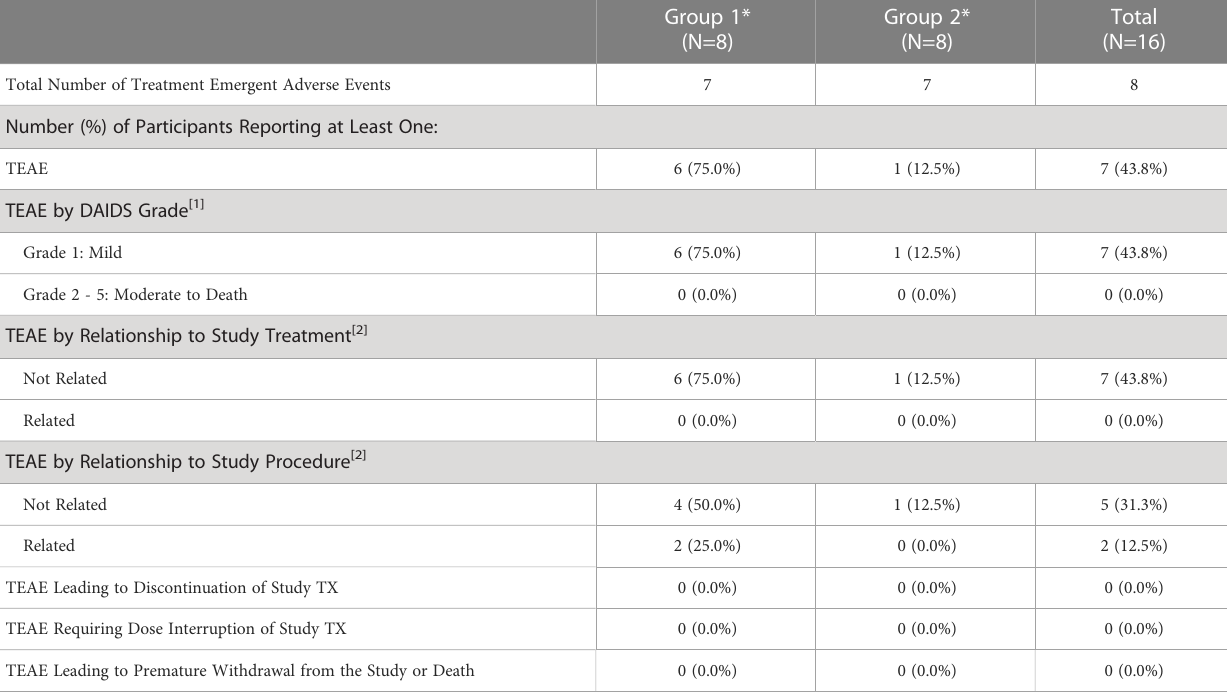
Supplemental Table 2. Median values at end of culture (day 12) and cumulative were lower after treatment (24 hours post dose) but changes from baseline post-dosing were not statistically signi fi cant (all p values > 0.80).